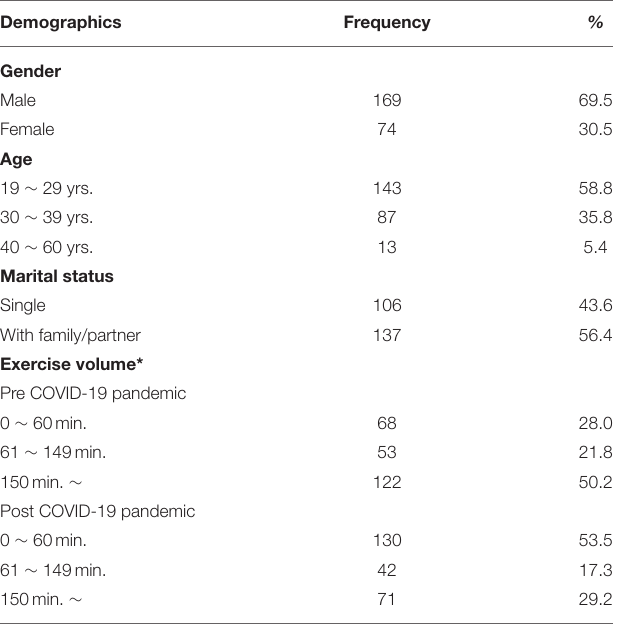
TABLE 1 | Demographics of the participants ( n =